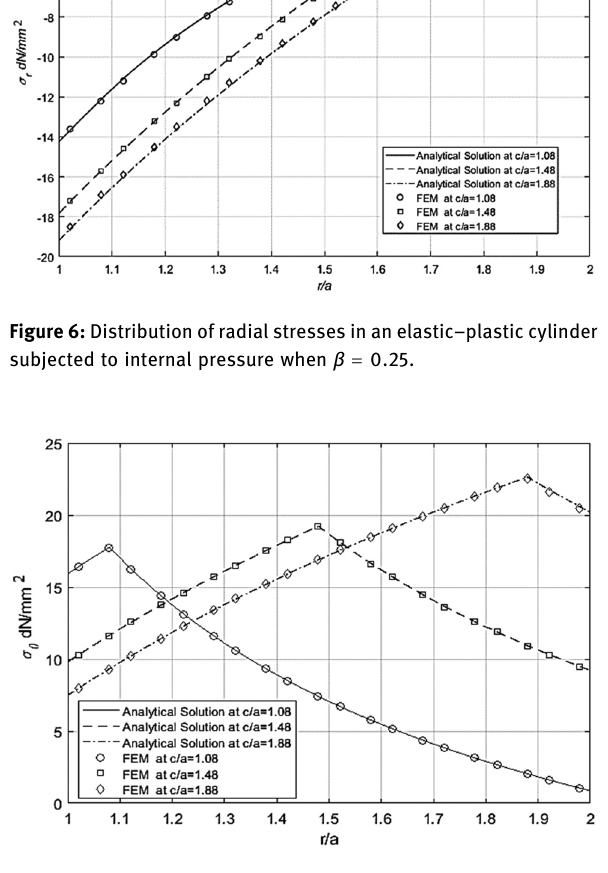
Figure 7: Distribution of hoop stresses in an elastic – plastic cylinder subjected to internal pressure when β −0.25 =